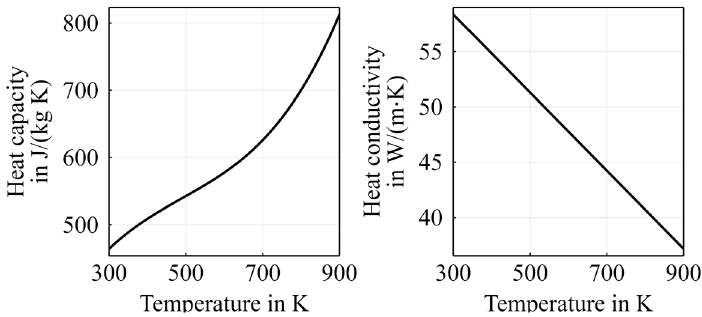
Figure 2. Thermophysical properties of steel 1.0035.